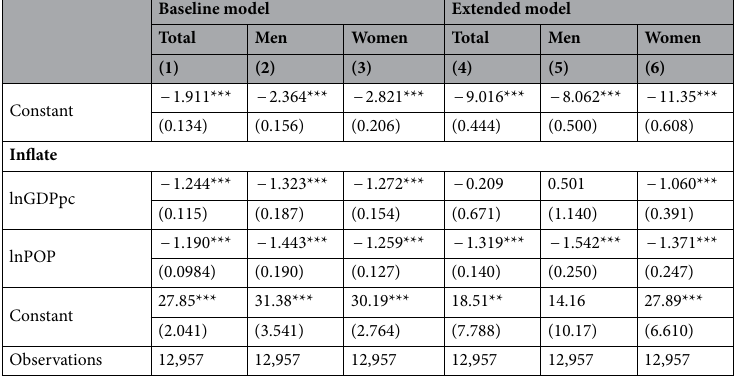
Table 3. Ex-ante and post effects on Olympic host countries. Robust standard errors in parentheses. * p < 0.1, ** p < 0.05, *** p < 0.01.